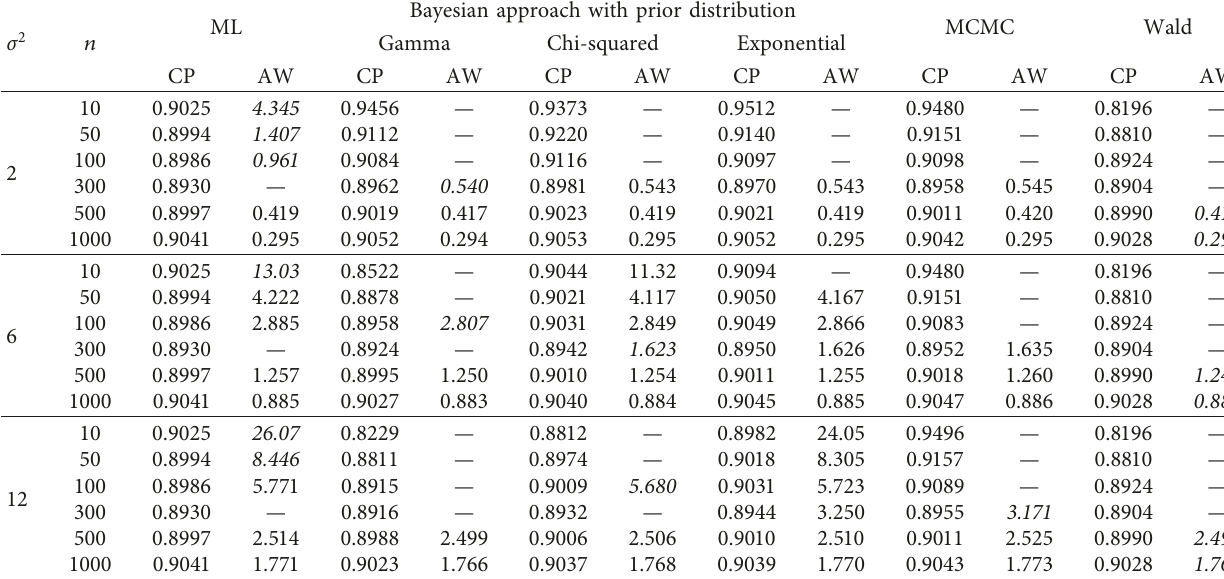
Table 2: The coverage probability (CP) and average width (AW) via 90% confidence interval.